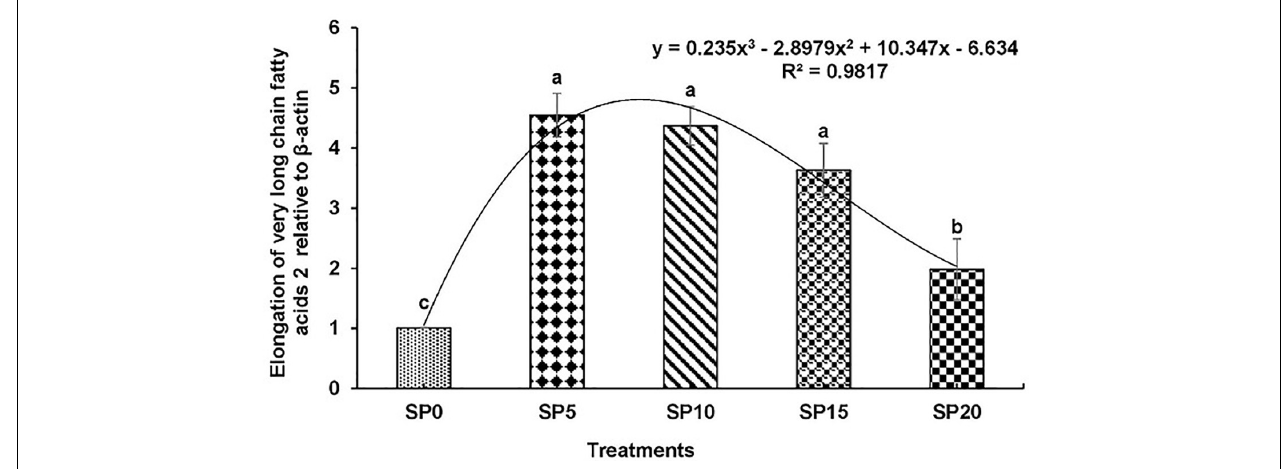
FIGURE 2 | Expression of elongation of very long chain fatty acids protein 2 ( elovl2 ) relative to β -actin in hepatopancreas of five different diet-fed Cyprinus carpio . Bars with different superscripts are significantly different ( n = 3). A polynomial (order 3) relationship was found between the diet and expression of fads2d6 ( R 2 = 0.982).